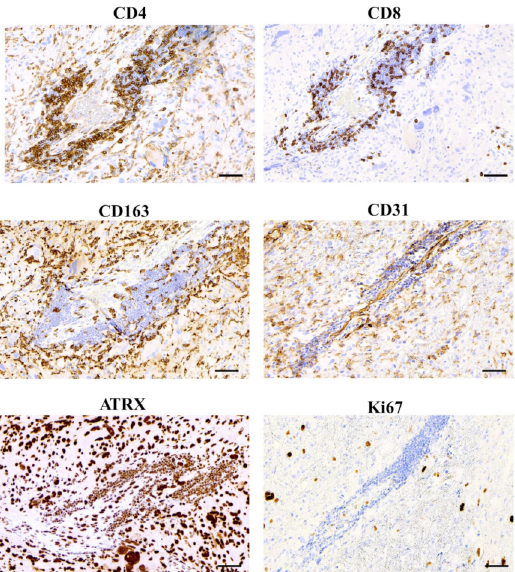
Figure 2. Glioblastoma Immune Microenvironment. Immunoperoxidase stained serial sections of a surgically resected glioblastoma to illustrate on the same microscopic field CD4+ and CD8+ tumor infiltrating lymphocytes (TILs) and CD163+ tumor associated macrophages (TAMs). The vascular profile, recognized by CD31+ (PECAM-1) endothelial cells lining the lumen filled by unstained red blood cells, is predominantly surrounded and infiltrated by CD4+ TILs. The remarkable contribution of CD163+ TAMs to the perivascular immune microenvironment is apparent. Nuclear ATRX staining of angio-invasive cancer cells of different dimensions, including giant cells, is shown in a serial section in which the vascular structure is barely recognized by small ATRX positive intravascular lymphocytes and few stromal-vascular ATRX negative cells ( bottom left ). The proliferative boost of glioblastoma cells is depicted by nuclear Ki67 labelling. Nuclear blue counterstaining by light Hematoxylin. Scale bars: 50 µ m.